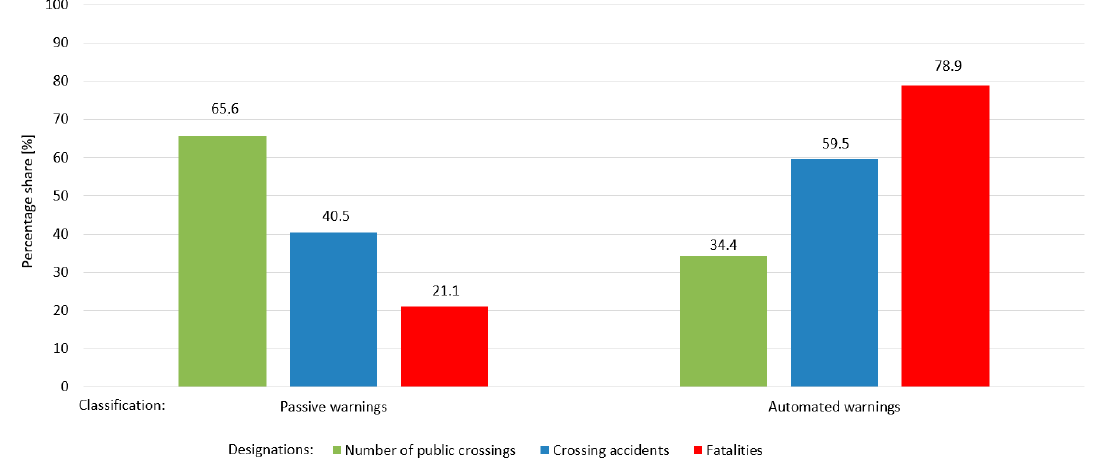
Figure 7. Percentage shares of number of railway level crossings (public crossings), accidents, and fatalities on the Canadian rail network.